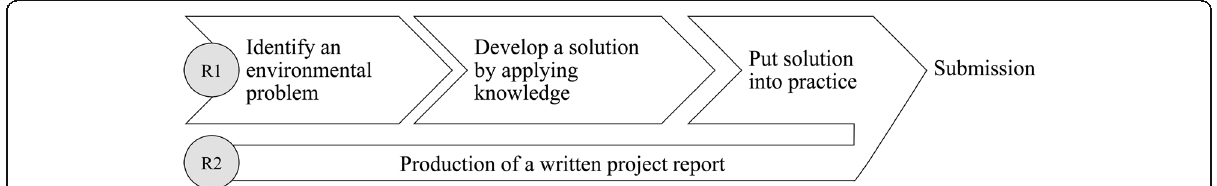
Fig. 1 Steps of participation in the BUW with two main requirements (R1: investigation of SSI and development of solution approach(es), R2: completion of project